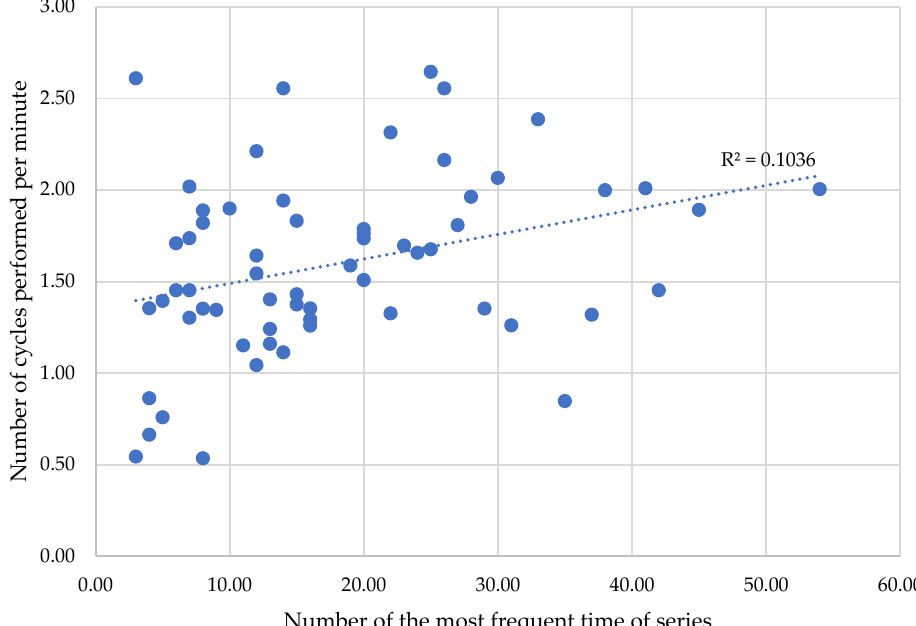
Figure 11. Dependence of the number of cycles performed per minute and the number of the most frequent time of series.